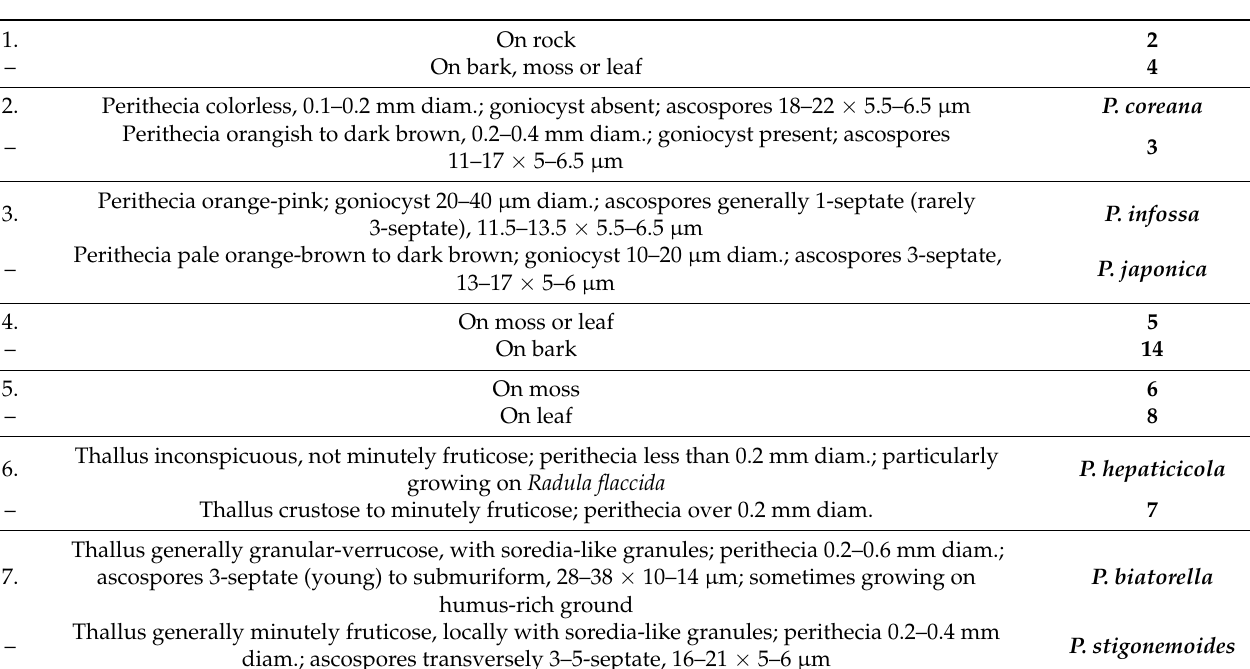
Table 3. Key to the species of Psoroglaena